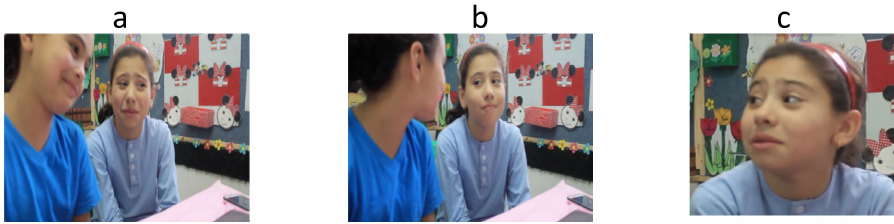
Figure 6. ( a ) Roqa (right) Laughs and then inhales. She squints skeptically at the screen; ( b ) looking at the parallelogram and then at Dari; ( c ) Seems confused and looks at